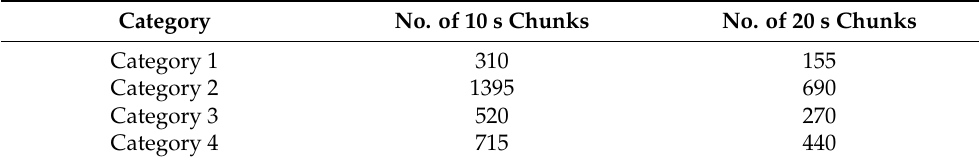
Table 5. Distribution of data among different aphasia categories for 10 s chunks and 20 s chunks.